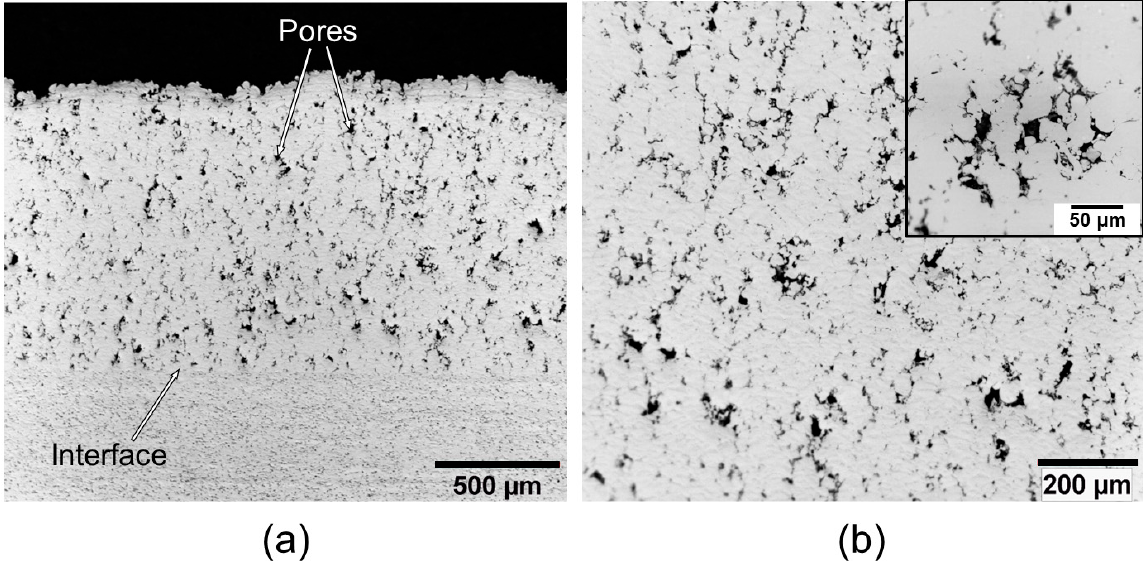
Figure 5. Cross-section micrograph of cold spray coating showing ( a ) overall coating layer and ( b ) magnified image with pores (inset shows some unfused powders).